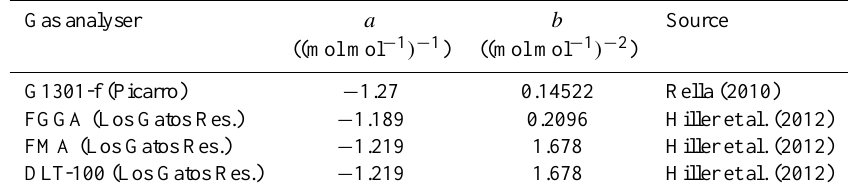
Table 3. Spectroscopic coefficients used in Eqs. (4) or (5) for different gas analysers. Gas analyser a b